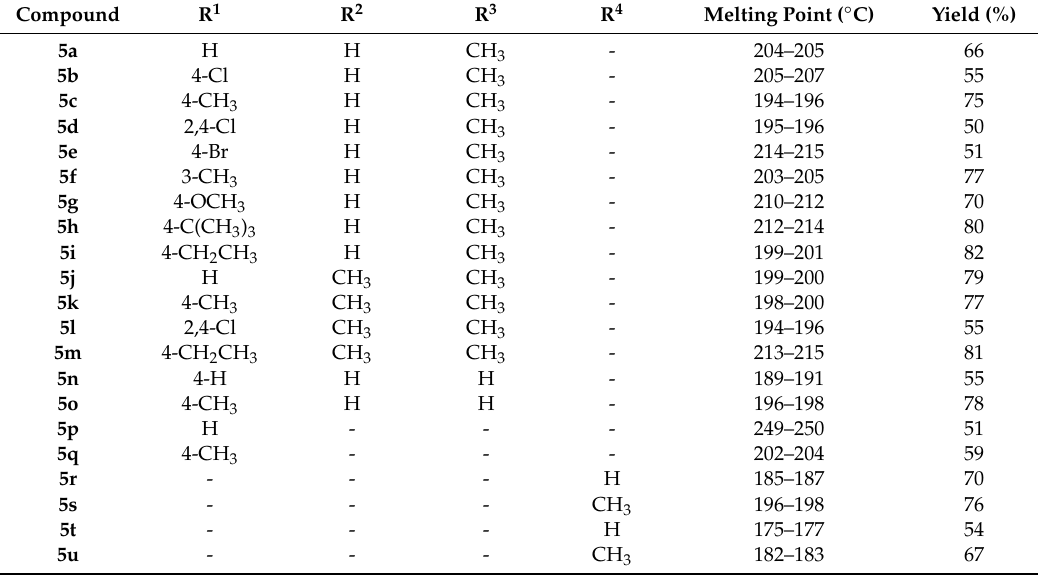
Table 1. The structures and the physicochemical properties of compounds 5a – 5u .